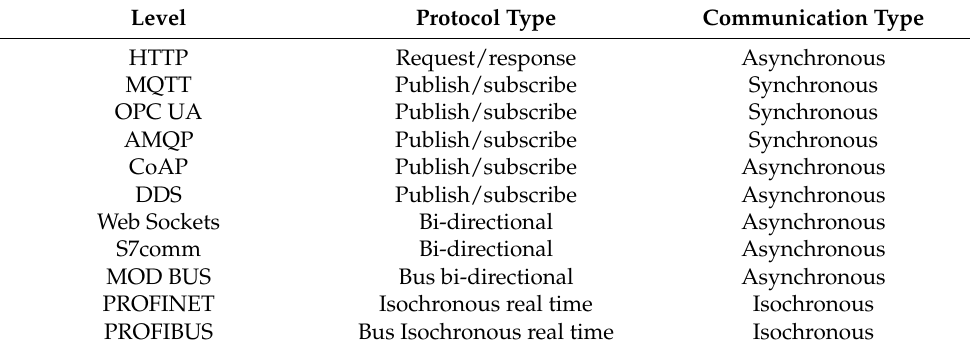
Table 2. Overview of application protocols for IIoT